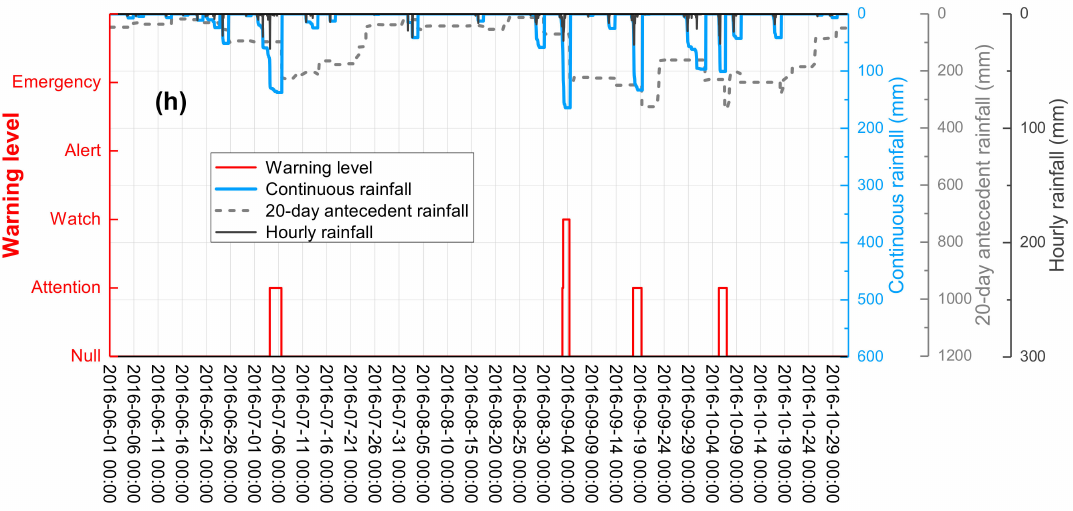
Figure 13. Progression of changes in rainfall and corresponding warning levels in the specific case study region during the rainy season of ( a ) 2009; ( b ) 2010; ( c ) 2011; ( d ) 2012; ( e ) 2013; ( f ) 2014; ( g ) 2015 and ( h )